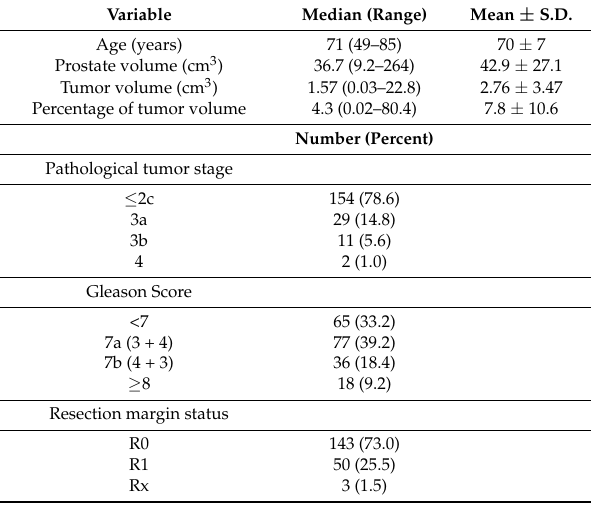
Table 1. Clinicopathological data (median and range) of the study